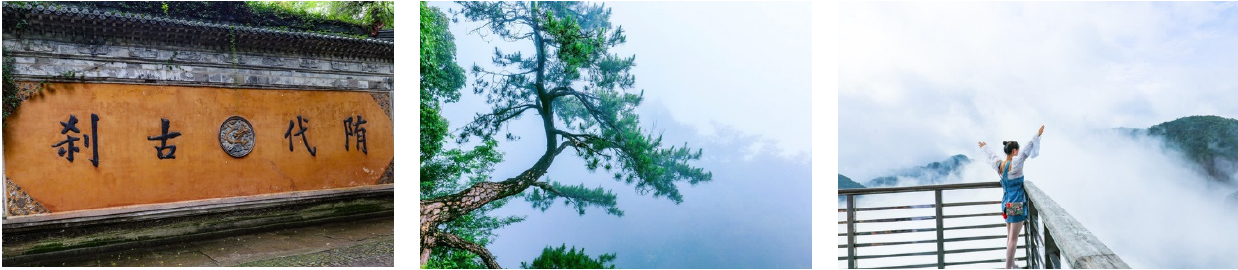
Figure 1. Examples of photographs in travelogues. The Chinese in left image shows “Ancient temple of Sui Dynasty”.